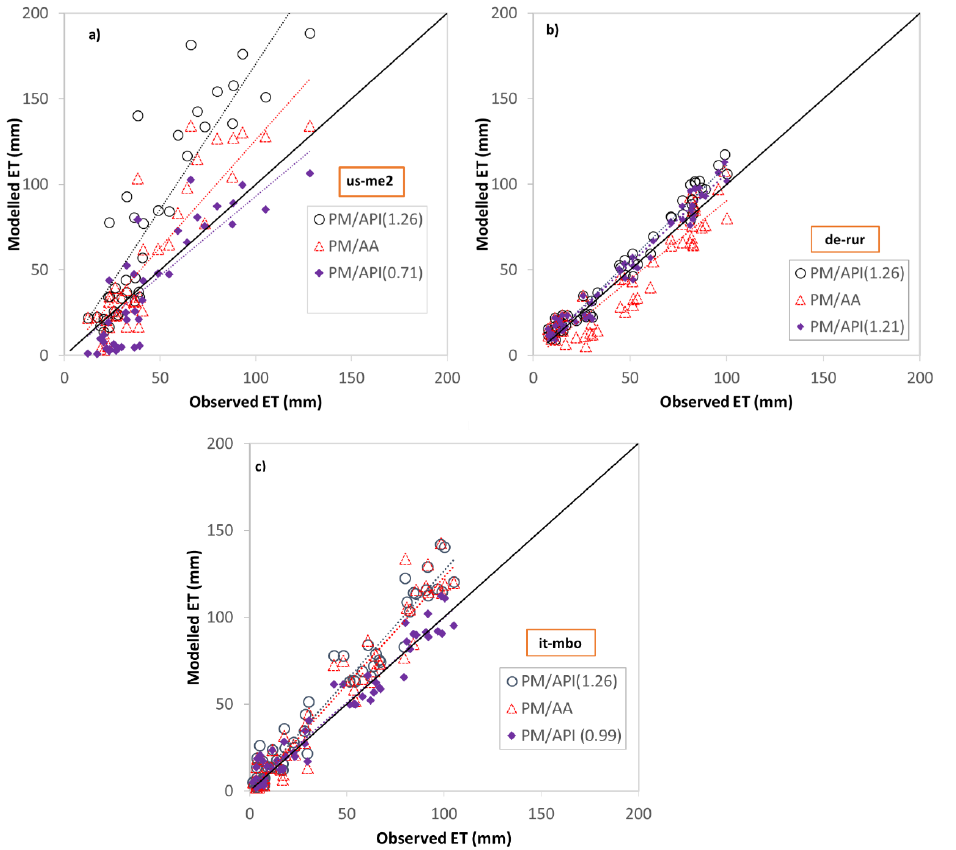
Figure 9. Scatter plots of observed and modelled ET values at Sister site ( a ), Rollesbroich site ( b ) and and Bondone mountain ( c ). (PM / AA = Penman / advection-aridity threshold model; PM / API(1.26) = and Bondone mountain ( c ). (PM/AA = Penman/advection-aridity threshold model; PM/API(1.26) = Penman / API corrected potential evapotranspiration threshold model, with α = 1.26; PM / API( α CAL ) = Penman/API corrected potential evapotranspiration threshold model, with α = 1.26; PM/API(α CAL ) = Penman / API corrected potential evapotranspiration calibrated threshold Penman/API corrected potential evapotranspiration calibrated threshold model).